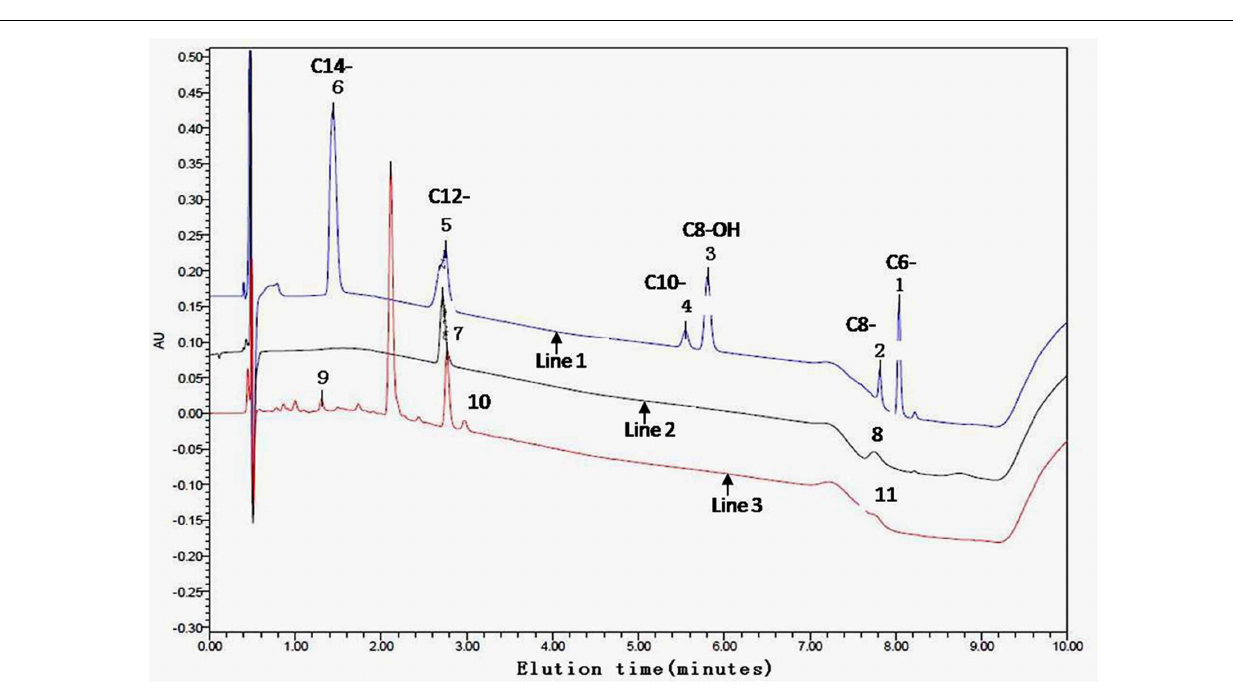
FIGURE 3 | Ethyl-acetate extracted culture supernatant analyzed by ultra performance liquid chromatography (UPLC). A gradient from 30 to 100% acetonitrile was applied at a flow rate of 0.3 ml/min in 0.5 min intervals following an isocratic flow of 0.2 min with the initial composition. The controls (line 1) used were mixtures of six AHL standards (C6-, C8-, C8-OH, C10-, C12-, and C14-) with the following retention times: peak 1 is C6-, peak 2 is C8-, peak 3 is C8-OH, peak 4 is C10-, peak 5 is C12-, and peak 6 is C14-AHL. UPLC showing the presence of at least one AHL compound in the tested samples 17 (line 2) and 15 (line 3) as examples. Peaks 7 and 10 probably are C12-, peaks 8 and 11 are C8-, and peak 9 is C14-AHL,